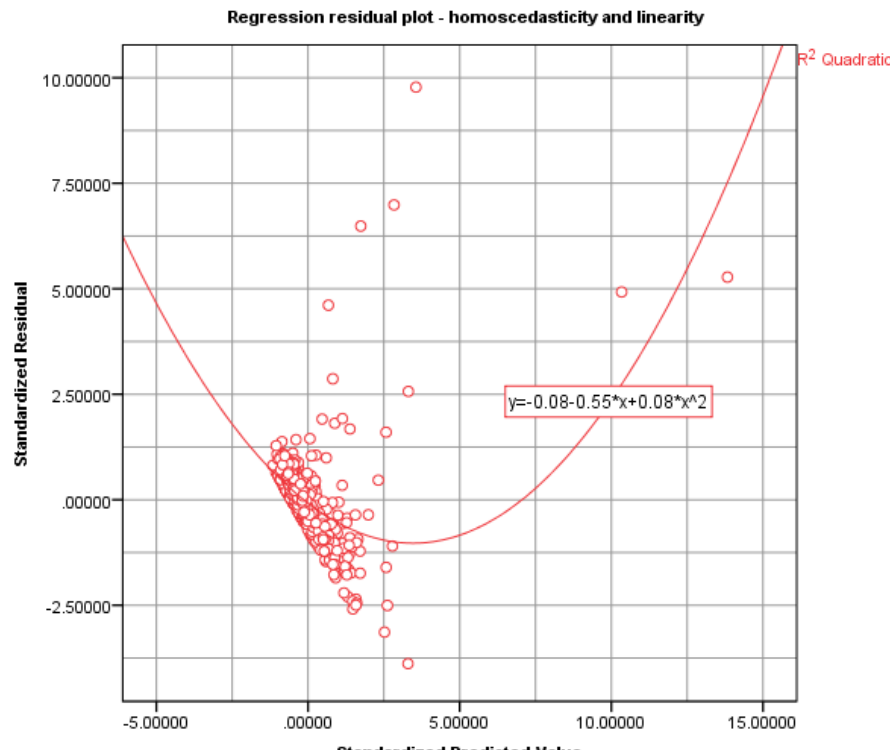
Figure 6. Regression residual plot—homoscedasticity and linearity.